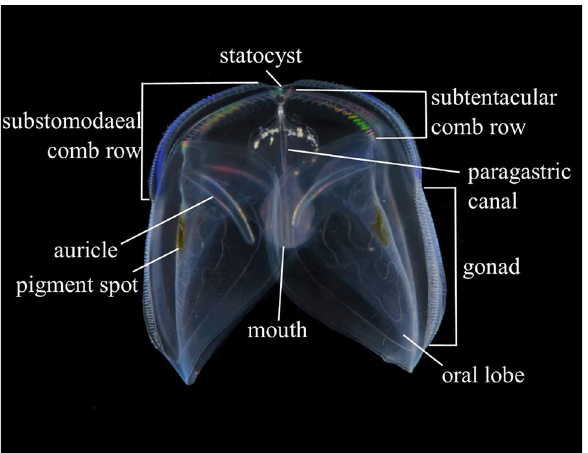
Figure 1. Anatomically labeled image of Ocyropsis maculata . With the exception of the pigment spots, all features noted here are found and arranged in the same manner in all known species of Ocyropsidae